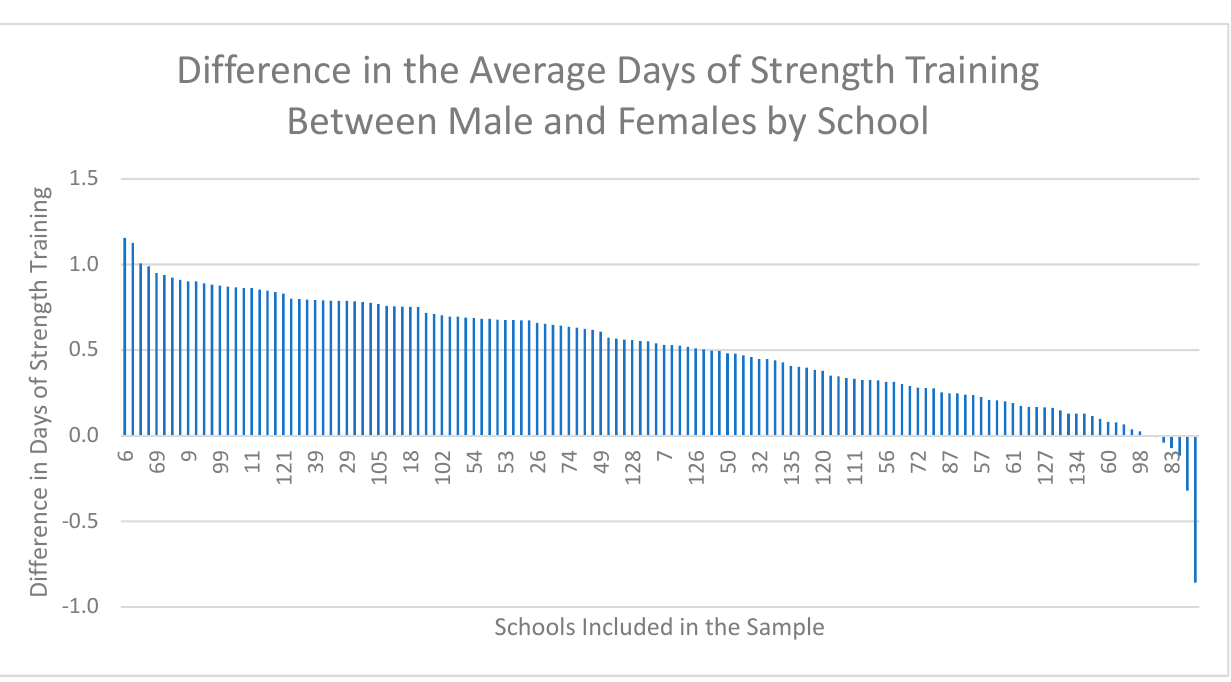
Figure 1. School-level differences between the percent of males and the percent of females meeting the CSEP guidelines from Year 7 (2018–2019) of the COMPASS study. Note: The difference is calculated as the percentage of males meeting guidelines minus the percentage of females meeting guidelines.